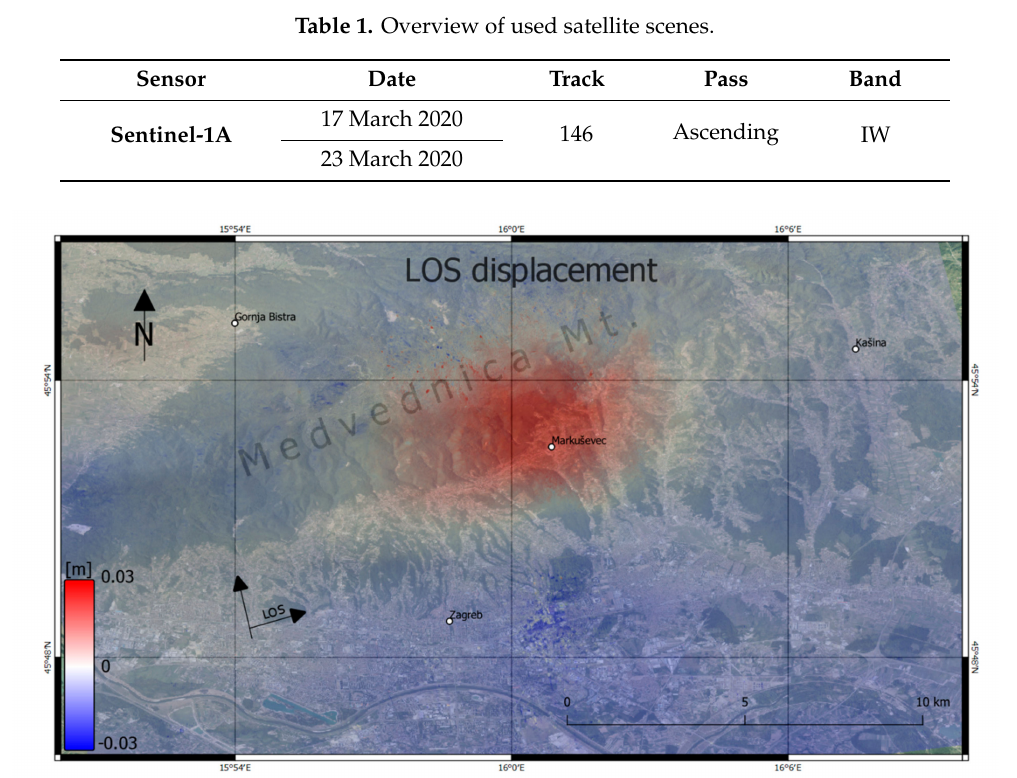
Figure 11. Unwrapped interferogram map indicating co-seismic line-of-sight (LOS) deformation of